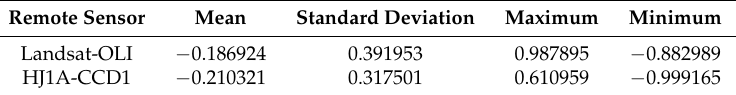
Table 12. The statistical results of Landsat-OLI and HJ1A-CCD1 NDWI